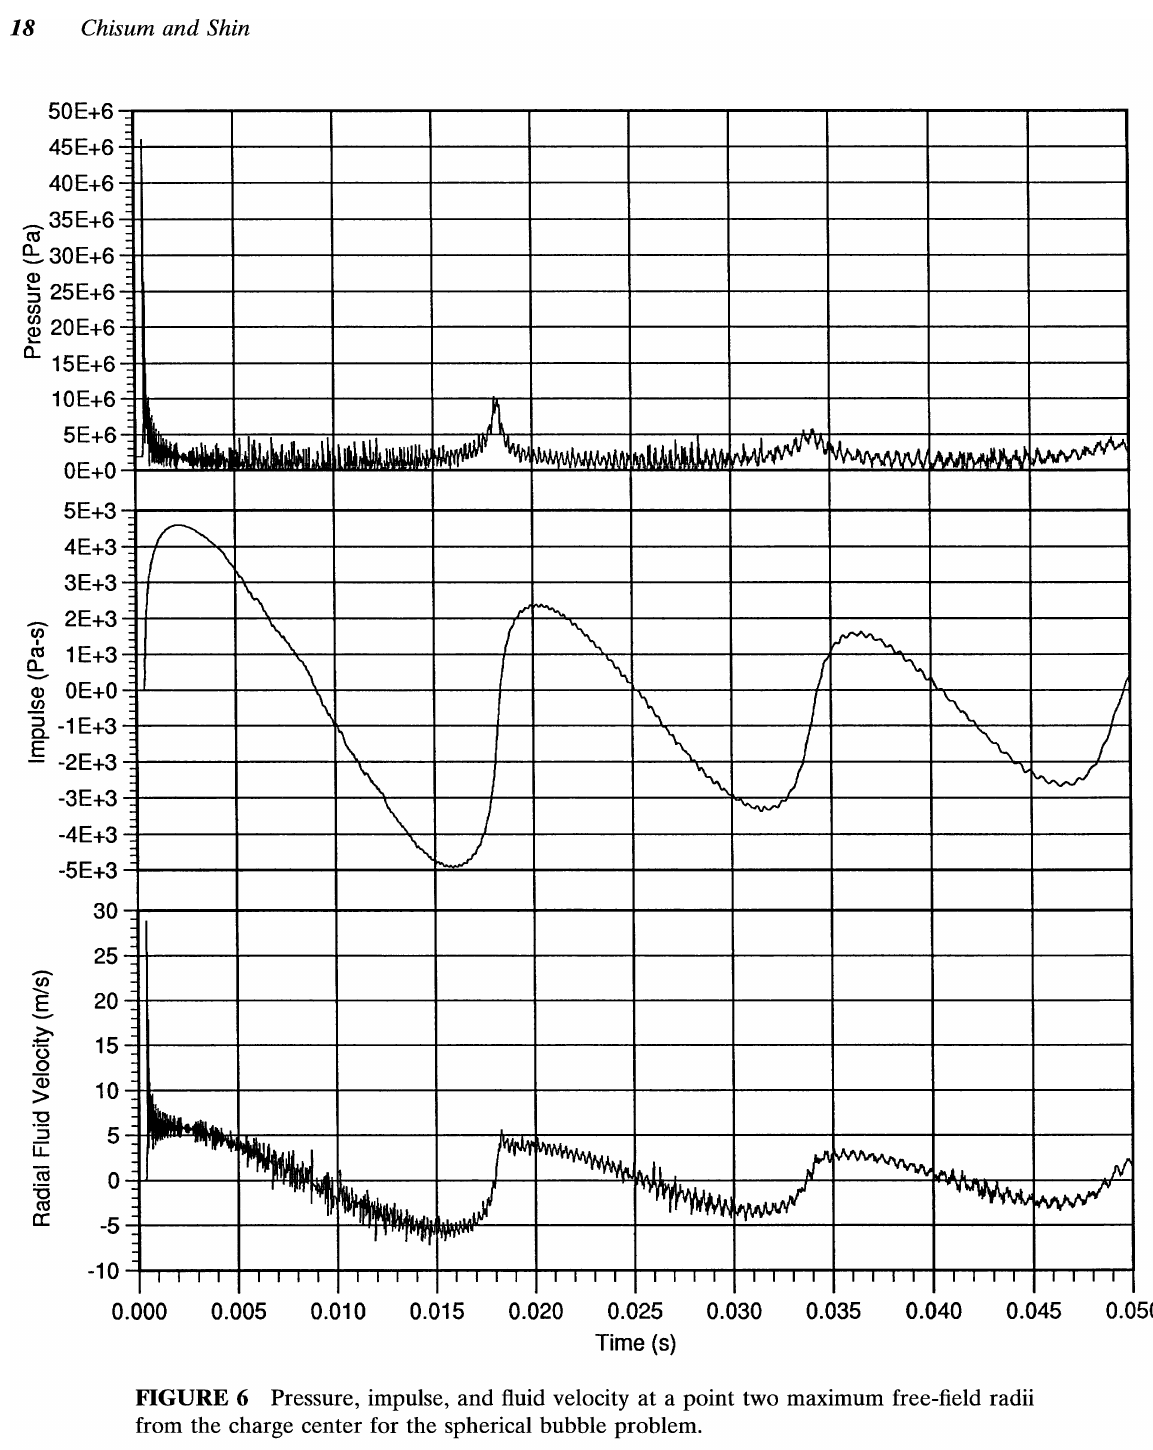
FIGURE 6 Pressure, impulse, and fluid velocity at a point two maximum free-field radii from the charge center for the spherical bubble